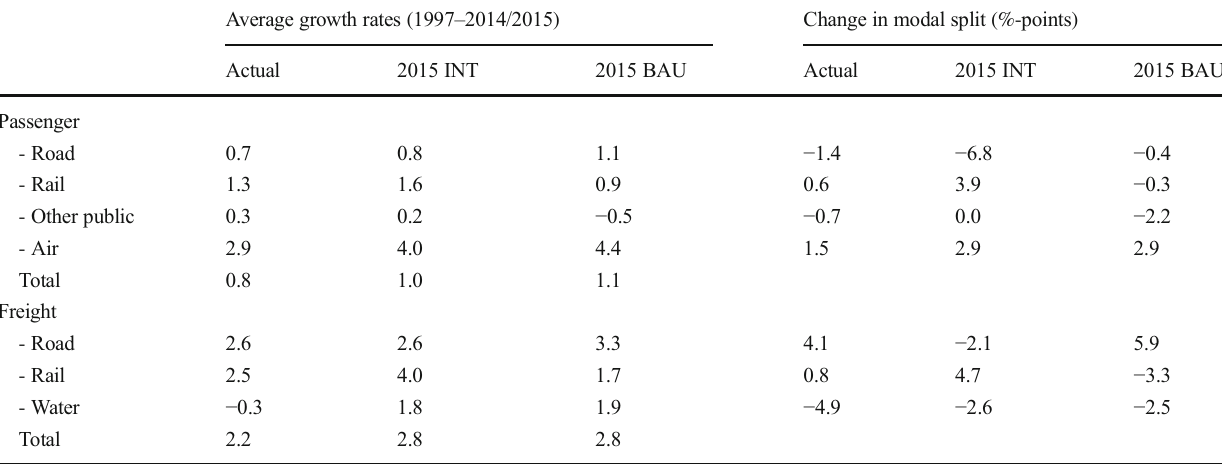
Comparison of actual transport developments and former scenario forecasts Average growth rates (1997 –